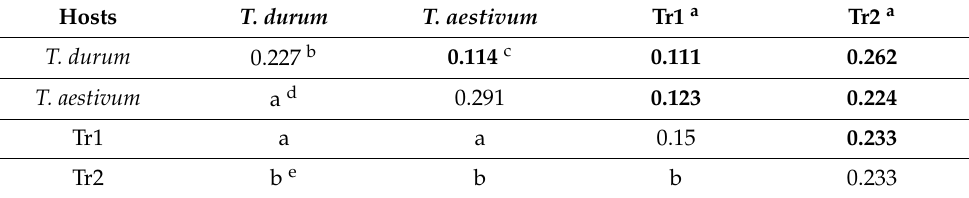
Table 3. Variation within and among host-specific collections of P. striiformis pathotypes in Russia. Hosts